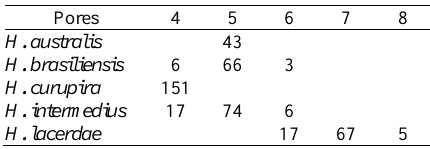
Table 3. Frequency distribution of total number of pores of cephalic lateral system along the ventral surface of the dentary in species of the Hoplias lacerdae